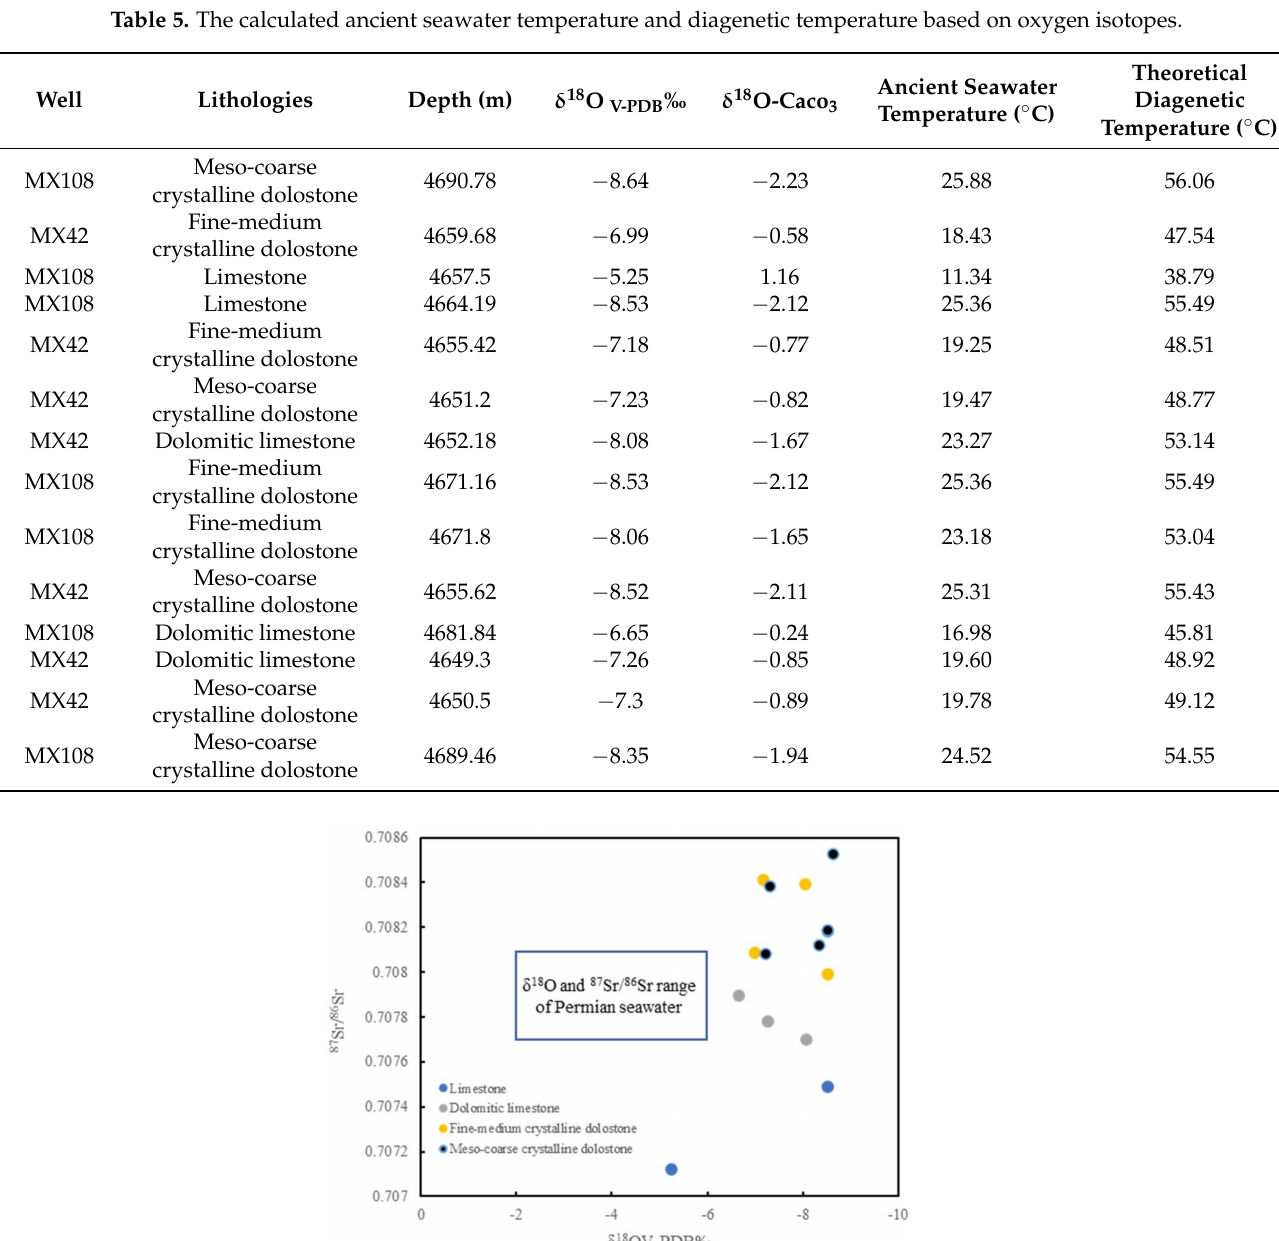
Table 5. The calculated ancient seawater temperature and diagenetic temperature based on oxygen isotopes.